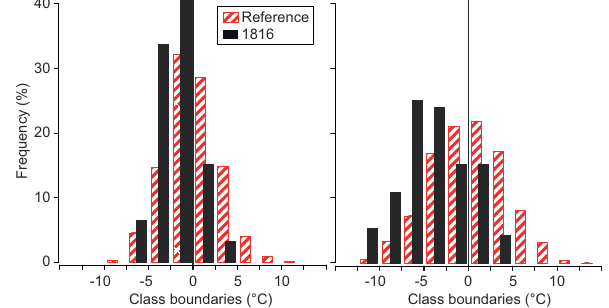
Fig. 3. Histograms showing the frequencies of occurrence (in percent) of temperature anomalies at sunrise (left panel) or 14:00LT (right panel) in the summer months (June to August) of 1816 (black) and in the reference period (red